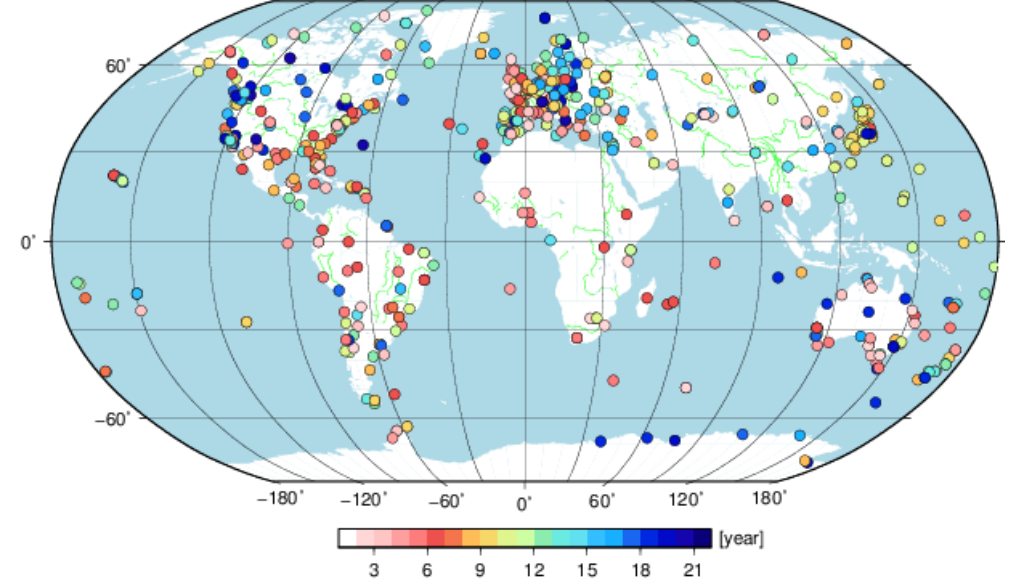
Figure 1. The global distributed stations with different observation time spans.